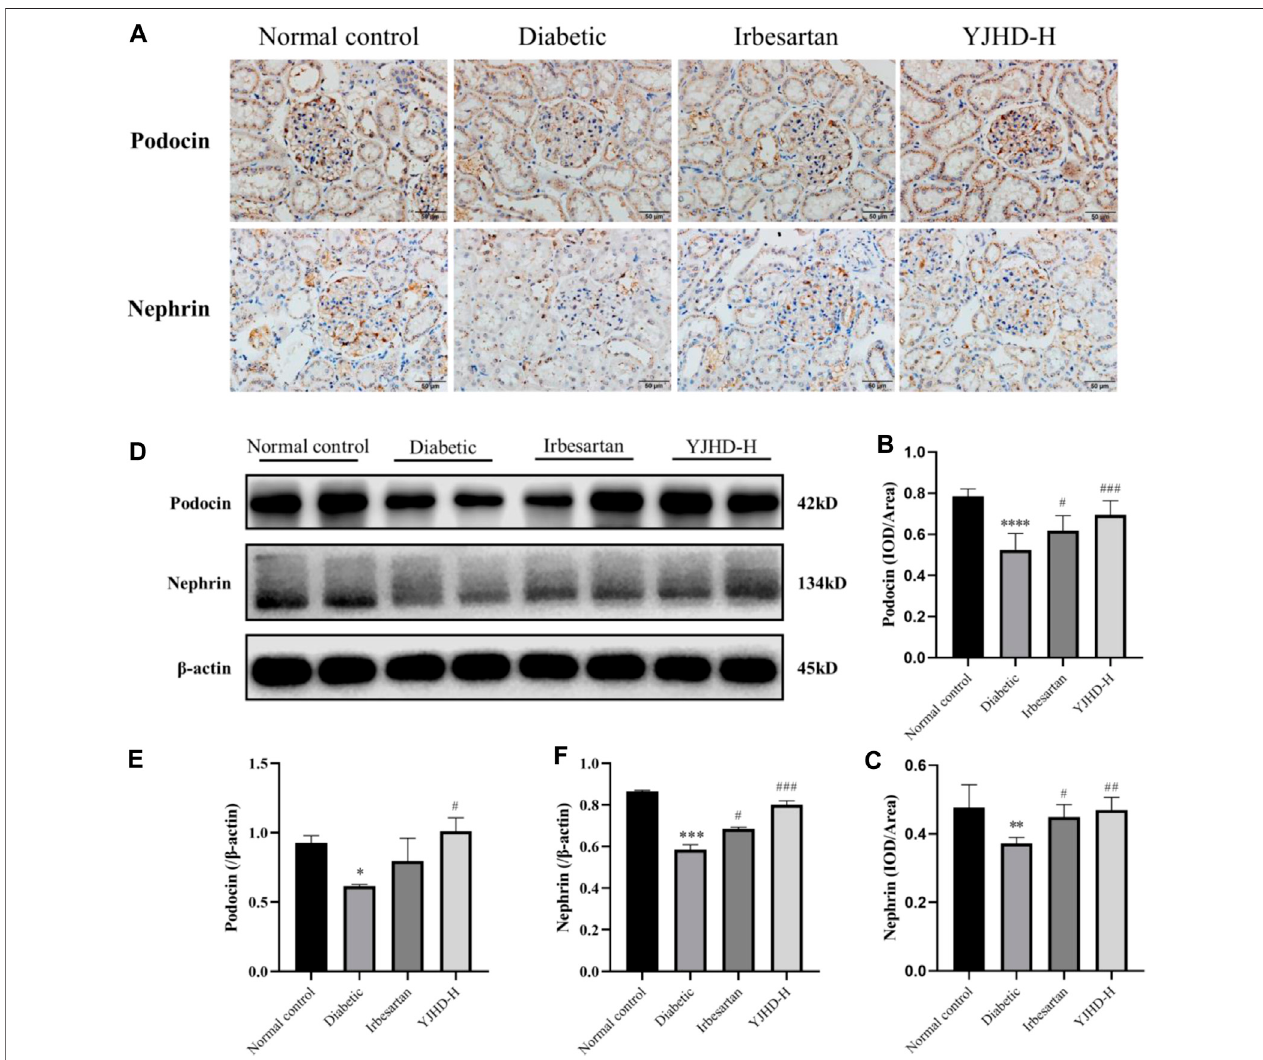
FIGURE 5 | Yiqi Jiedu Huayu decoction (YJHD) alleviates podocyte injury. (A) Podocin and nephrin expression were detected by immunohistochemistry. (B, C) Immunohistochemical staining results of podocin and nephrin were analyzed by Image-Pro Plus software. (D) Protein levels of podocin and nephrin in kidneys were detected by western blot. (E, F) Protein concentration analysis. Data are expressed as * p < 0.05, ** p < 0.01, *** p < 0.001, **** p < 0.0001: compared with the normal control group; # p < 0.05, ## p < 0.01, ### p < 0.001: compared with the diabetic group.